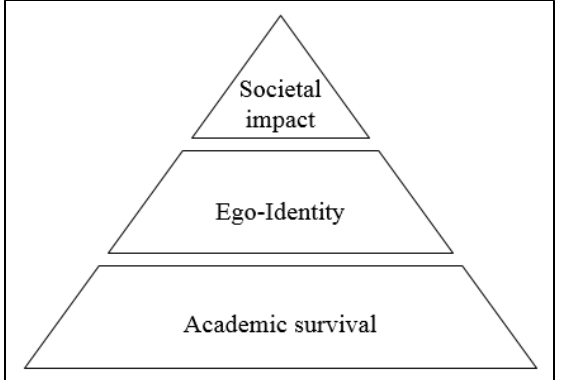
Figure 5. Scientists’ needs pyramid. Source: own illustration.